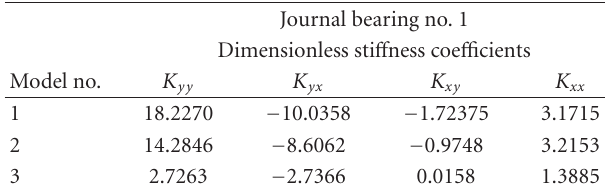
Table 2: Dimensionless sti ff ness coe ffi cients of the oil-film journal bearing no. 1, evaluated at 3000 rpm, included in the models no. 1, no. 2, and no. 3 ( y : vertical direction, x : horizontal